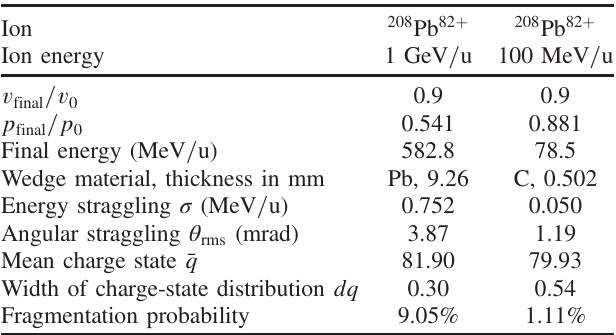
TABLE VII. Examples of how the beam quality declines as it passes through well-chosen materials to achieve the specified velocity reduction. The quantities are estimated by using the EPAX formula and the codes GLOBAL and ATIMA .